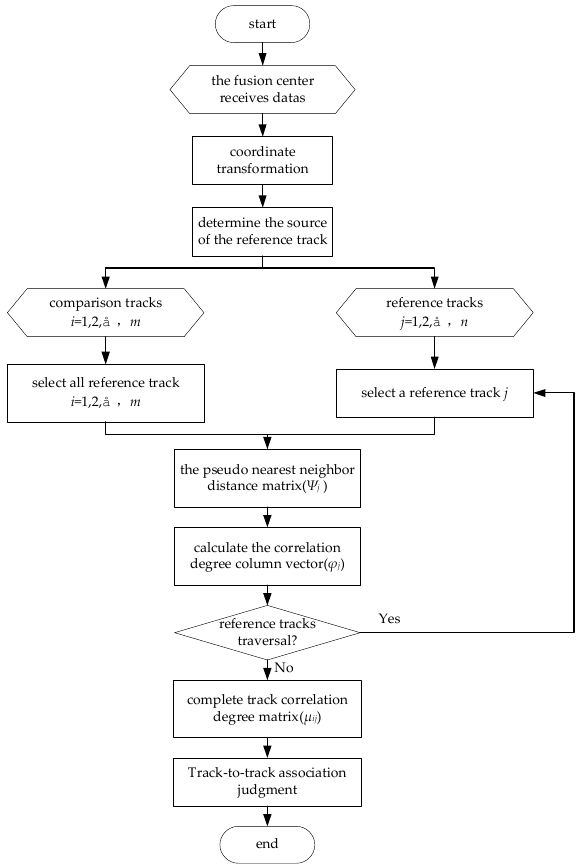
Figure 1. Flow chart of asynchronous unequal rate TTTA algorithm.